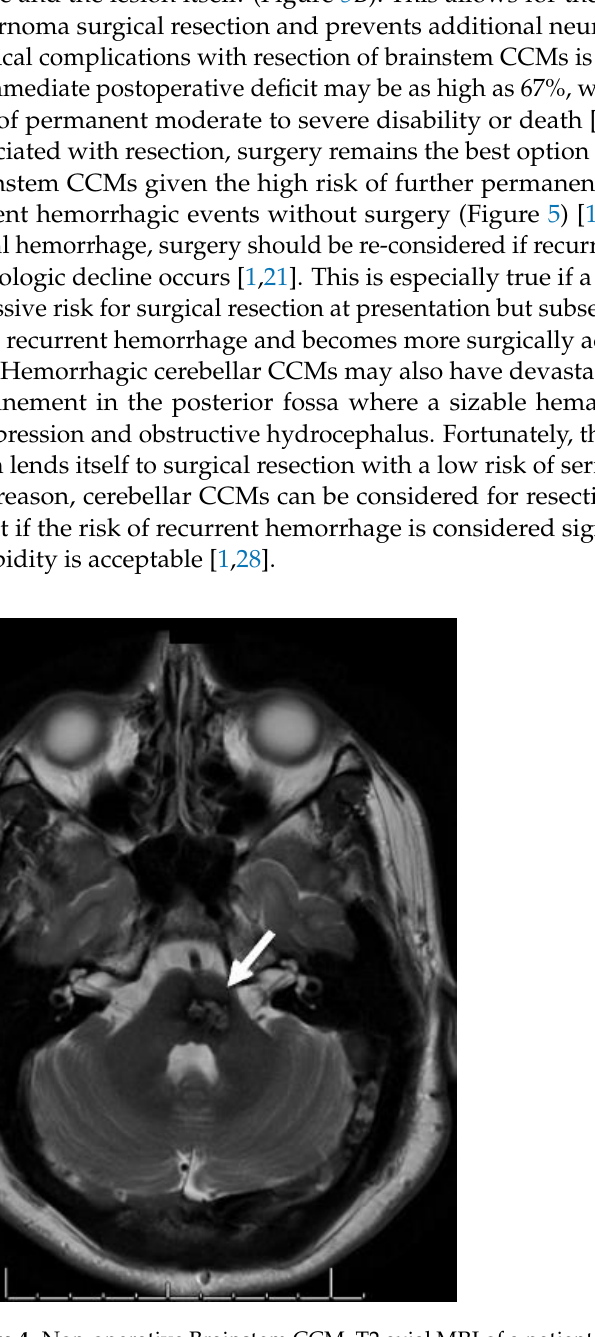
Figure 4. Non-operative Brainstem CCM. T2 axial MRI of a patient with familial CCMs found to have a non-hemorrhagic brainstem lesion (white arrow) that does not come to the surface. This patient was closely monitored without operative intervention.